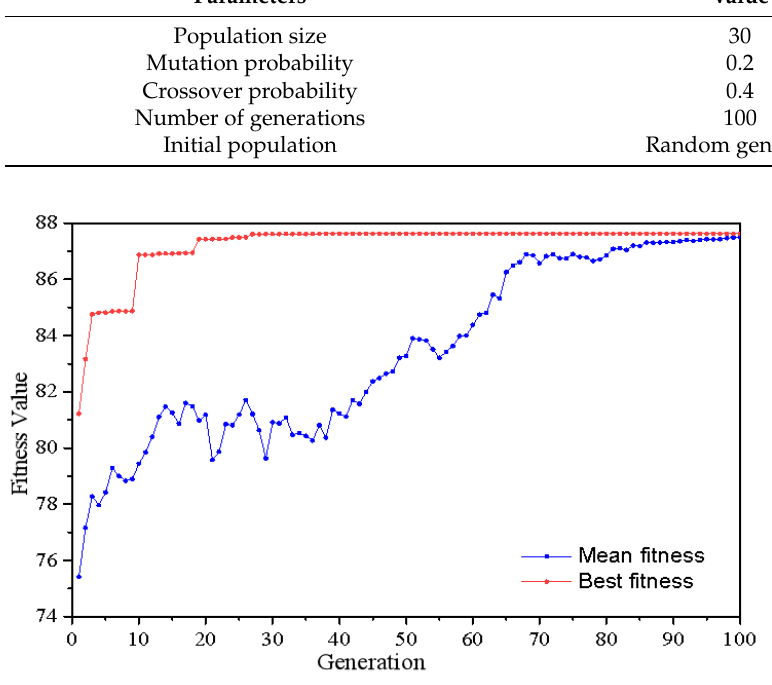
Figure 15. Best fit convergence of genetic algorithm (GA)–BPNN.